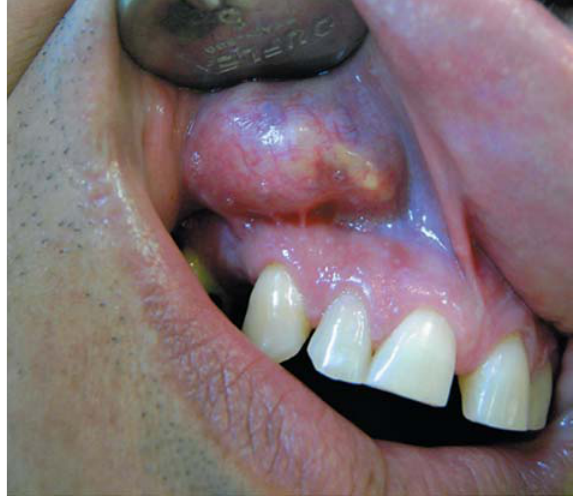
Figure 1- Intraoral photograph at initial examination showing well circumscribed and sessile nodule in the right upper vestibule, measuring 2.0 cm in diameter and with a normal-appearing oral mucosa